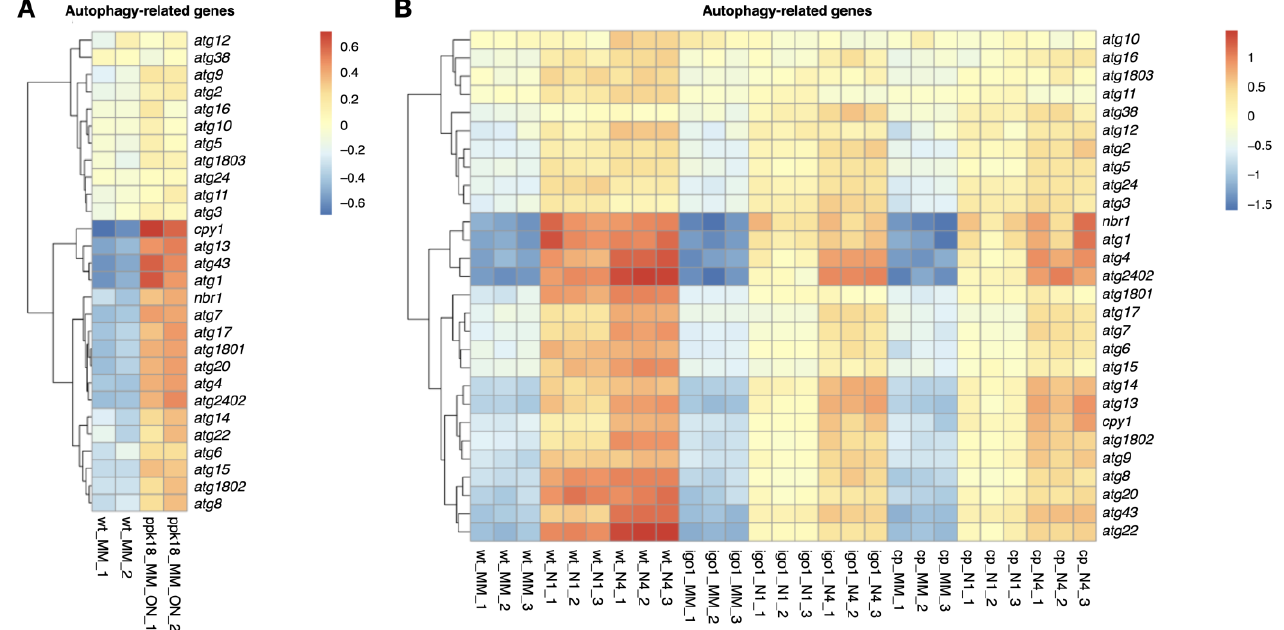
Figure 6. Heat maps of RNA-seq data showing autophagy-related genes induced by the Greatwall – Endosulfine switch. ( A ) Heat map showing autophagy-related genes upregulated by RNAseq after 20 h of Greatwall overexpression ( nmt1:ppk18 + ) in minimal medium compared to the wild type. Two independent experimental replicates are shown. ( B ) Autophagy-related genes induced by nitrogen starvation in wild type (wt), igo1 ∆ (igo1), and cek1 ∆ ppk18 ∆ (cp) in MM, MM-N 1 h (N1), and MM- N 4 h (N4). Three independent experimental replicates are shown.